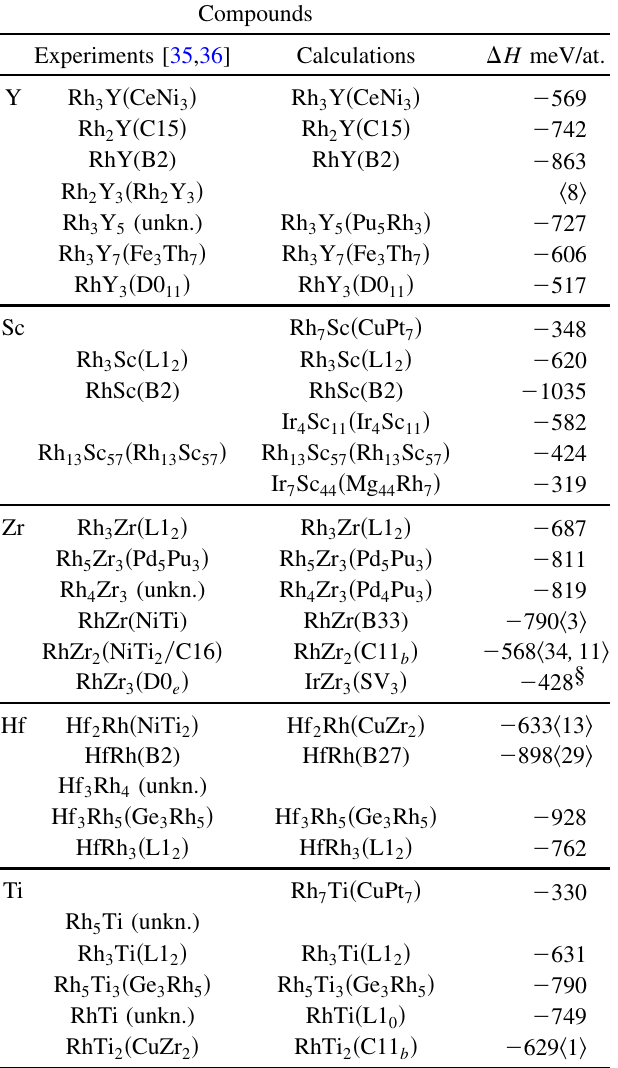
TABLE IV. Compounds in Rhodium binary alloys. All sym- bols are as in Table III. Compounds Experiments [35,36]